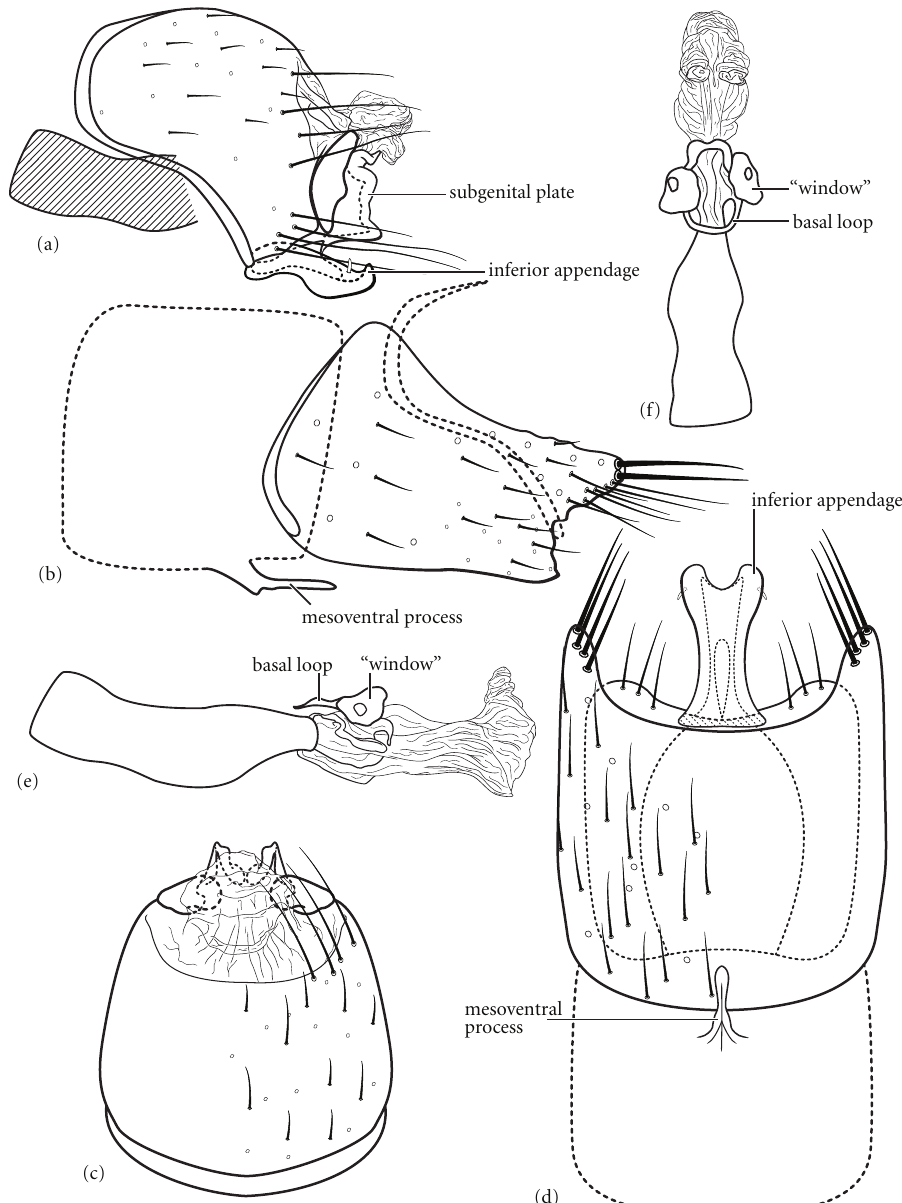
Figure 2: Leucotrichia bicornuta sp.n., male genitalia: (a) segments IX-X, left lateral (base of phallus crosshatched); (b) segments VII-VIII and segment IX anterolateral margin, left lateral; (c) segments IX-X, dorsal; (d) segments VII–IX, ventral; (e) phallus, left lateral; (f) phallus,